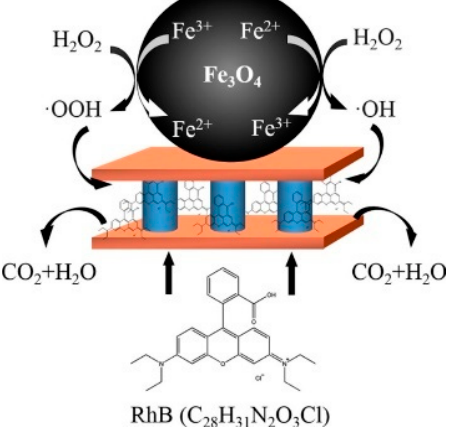
Figure 24. Fe 3 O 4 -decorated Al-pillared bentonite (Fe 3 O 4 /Al-B) as a peroxidase-like nanozyme for the degradation of Rh B. (Reprinted with permission from [194] . Copyright © 2015 Elsevier B.V. All rights reserved).